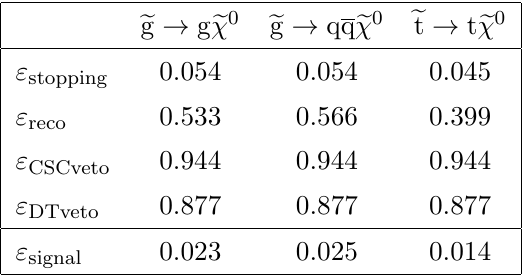
Table 1 . Summary of the values of " stopping , " CSCveto , " DTveto , and the plateau value of " reco for di(cid:11)erent signals, for the calorimeter search. The e(cid:14)ciency " stopping is constant for the range of signal masses considered. The e(cid:14)ciency " reco is given on the E g or E t plateau for each signal. than for top squarks of the same mass because gluinos are more likely to produce doubly charged